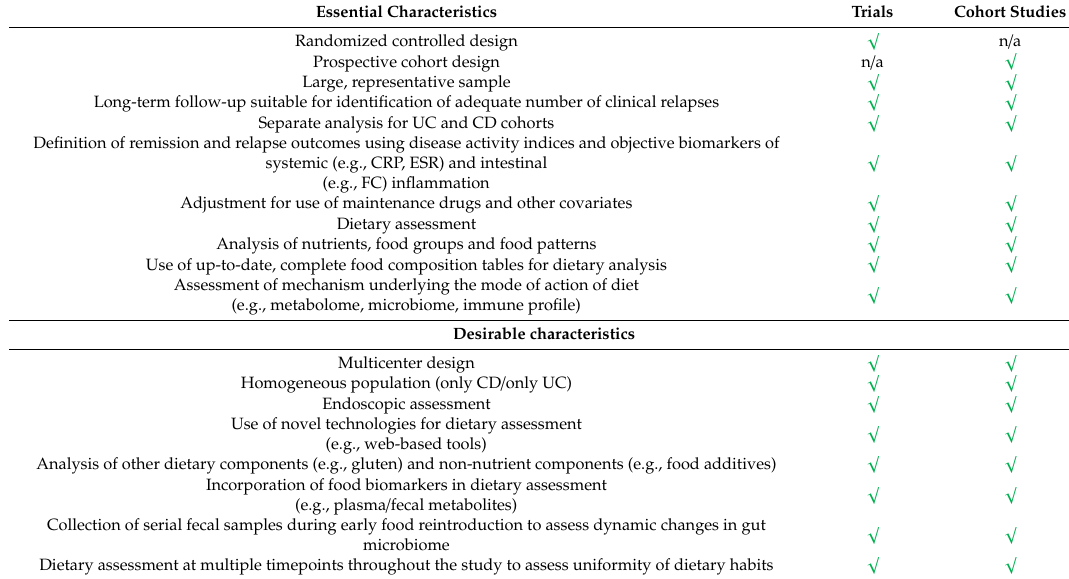
Table 2. Essential and desirable characteristics of intervention trials aiming to assess the e ffi cacy of dietary strategies for the maintenance of clinical remission and cohort studies aiming to investigate the association of dietary components with the risk of relapse in patients with IBD.